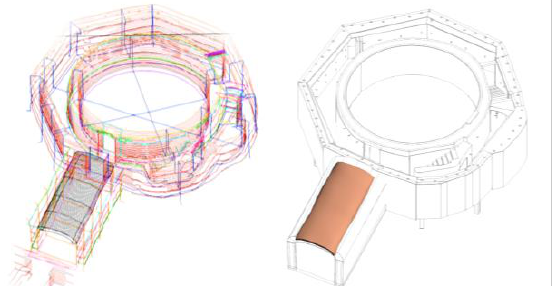
Fig. 8. The process of converting a 3D surafce into a parametric object with specific properties.